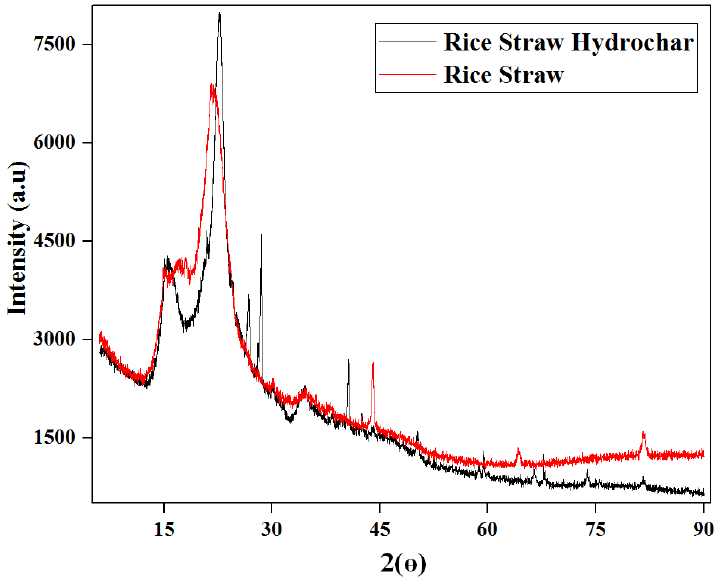
Figure 8. The XRD analysis of rice straw and the optimized hydrochar.